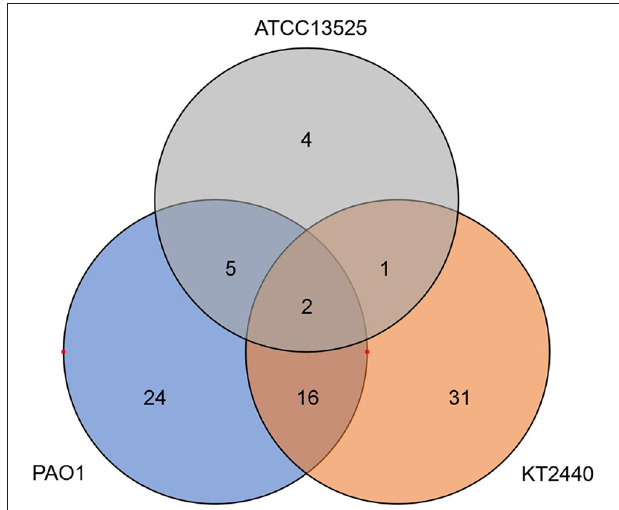
FIGURE 3 | The quantity of metabolites commonly or strain-specifically regulated by P. aeruginosa PAO1, P. putida KT2440, and P. fluorescence ATCC 13525 T